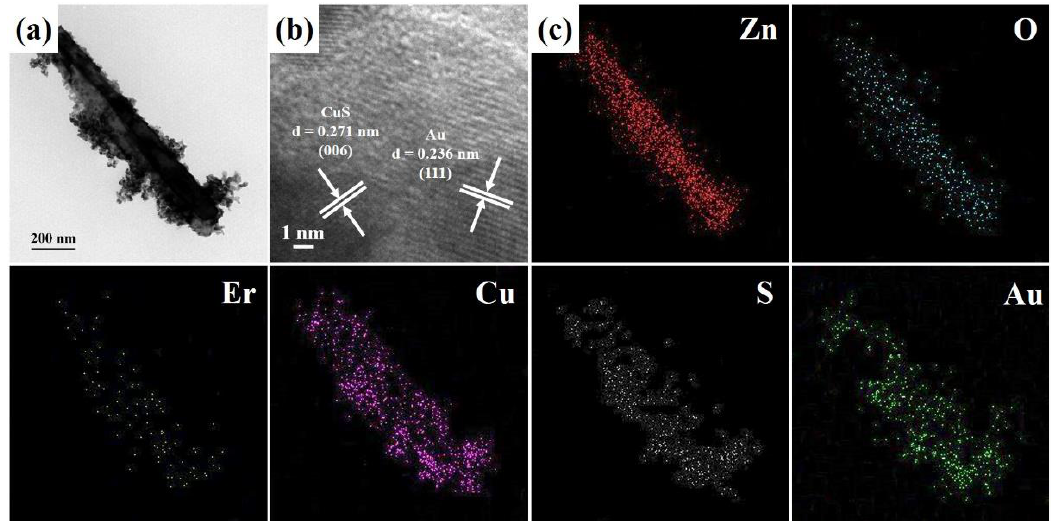
Figure 4. ( a ) FETEM, ( b ) HRTEM, and ( c ) EDS mapping images of an Er-doped ZnO/CuS/Au core-shell nanowire fabricated at the Au-sputtering time of the 30 s.